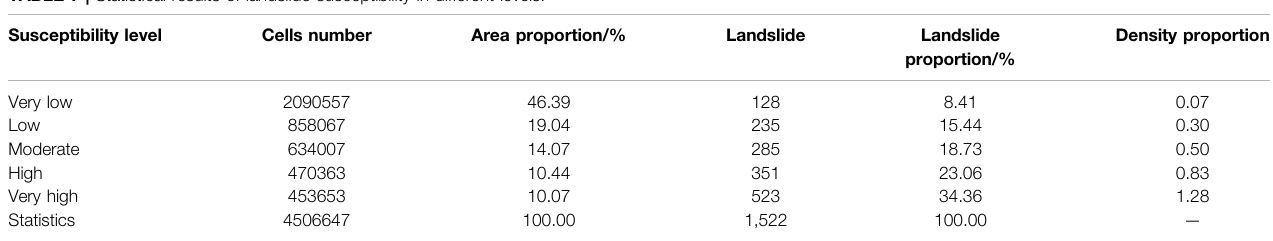
TABLE 7 | Statistical results of landslide susceptibility in different